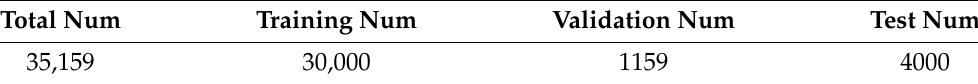
Table 3. Word translation